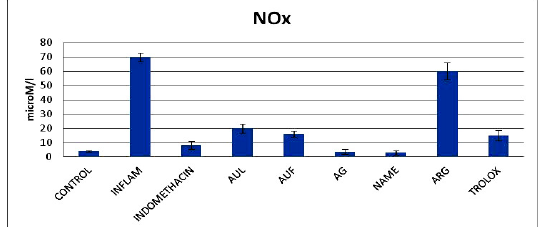
Fig. 4. Serum nitric oxide